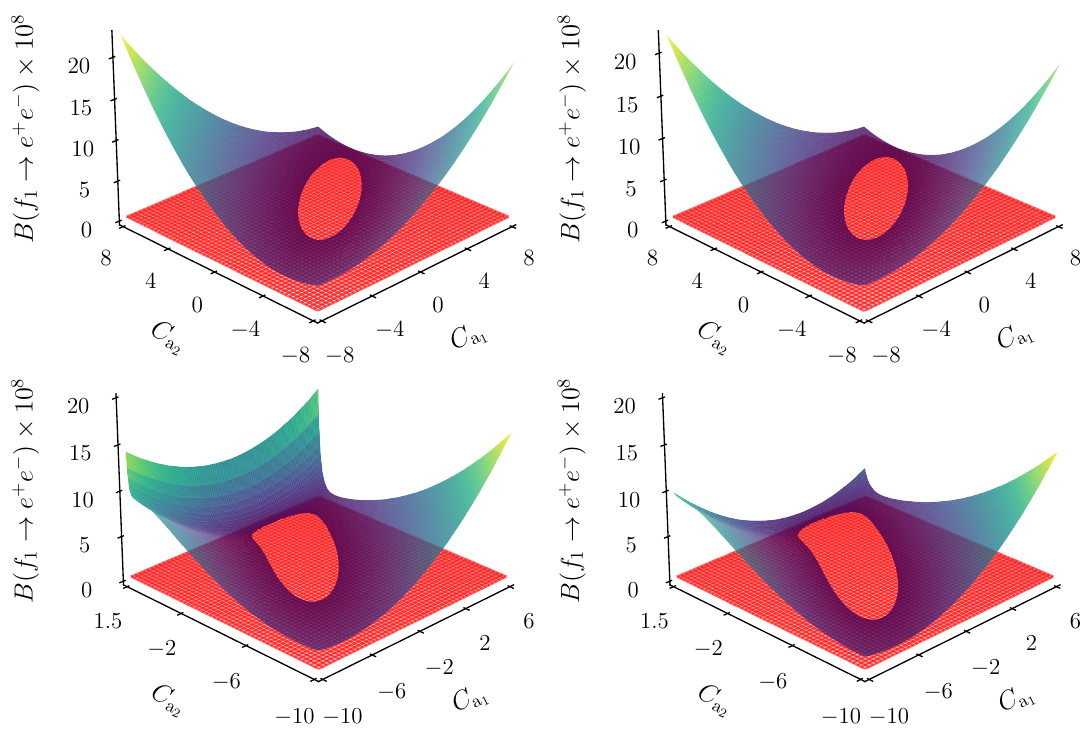
Figure 10 . Surface plots of B ( f 1 → e + e − ) ( blue-yellow textured ), equation (5.13), as obtained with the minimal ( top ) and extended ( bottom ) VMD parameterization (reference point for the latter) and using the central value of C s = 0 . 93(11) , equation (4.24), Γ ρ 0 ( q 2 ) = Γ (4 π ) ( left ), equation (3.12), and Γ ρ 0 ( q 2 ) = Γ ( ωπ,ππ ) value of the measurement B ( f 1 → e + e − ) = 5 . 1 +3 . 7